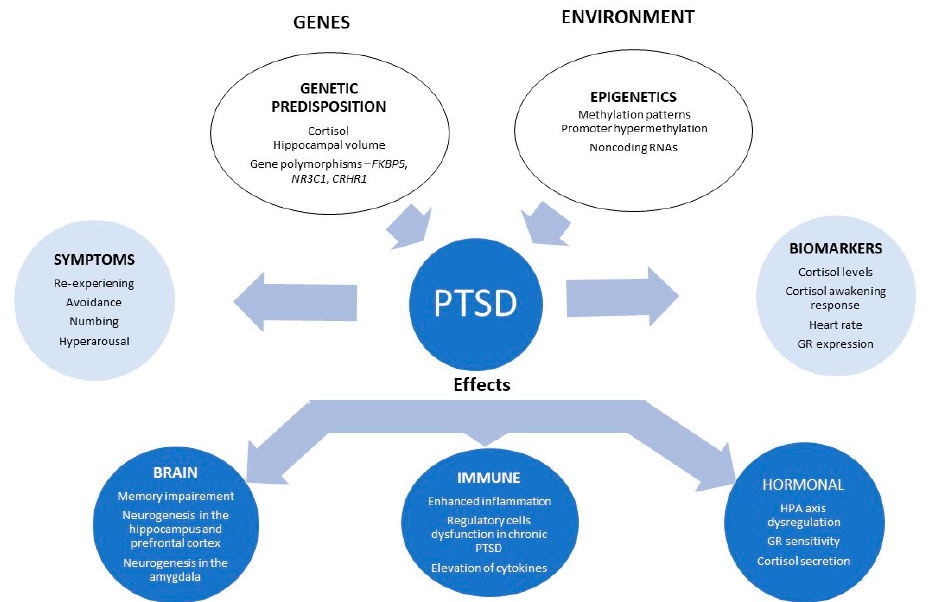
Figure 3. Gene/environment interaction in PTSD. Ranging from genetic and environment interactions through to symptoms, possible biomarkers and brain and hormonal changes. Abbreviations: HPA axis: hypothalamic–pituitary–adrenal axis; GR: glucocorticoid receptor. Adapted from [209] .